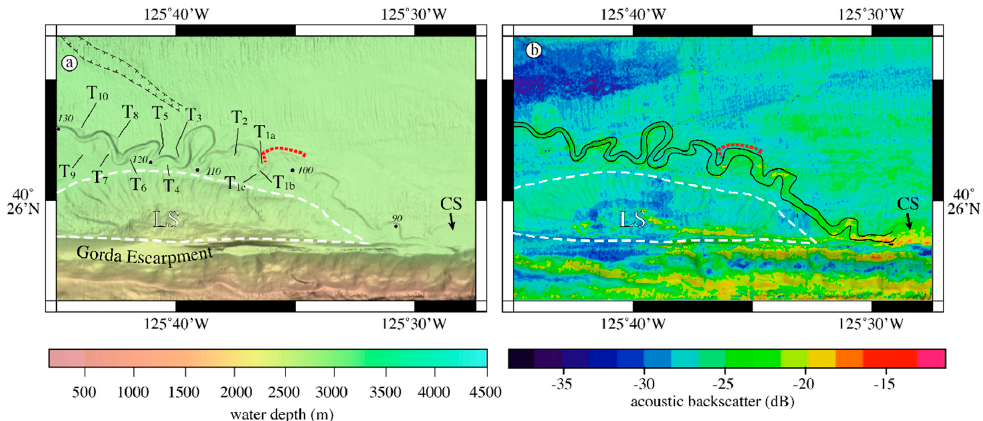
Figure 13. ( a ) Map view of multibeam bathymetry of the lower sinuous reach and large landslide deposit (white dashed polygon labeled LS) shed off the Gorda Escarpment. Terraces (T) are numbered and discussed in the text. Red dashed bracket is the zone of 3–5 m of relief that presently blocks the channel, discussed in the text. Black hachured lines outline a relict channel. Ten km black circles mark distances in km in italics from the junction of Mendocino and Mattole Canyons; ( b ) Map view of multibeam backscatter of the lower sinuous reach that shows that the high backscatter from up-channel slowly decreases in intensity with distance down-channel. CS is crevasse splay. See Figure 2 for location.